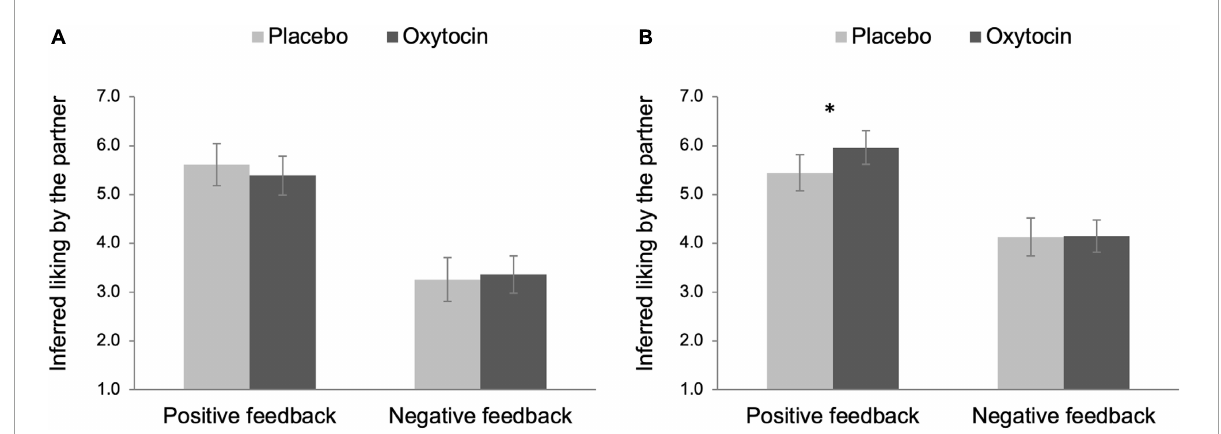
FIGURE4 Partner perception before (A) and after (B) the in-person interaction as a function of intranasal spray (placebo vs. oxytocin) in each feedback condition. Higher number indicates that participants perceived their partner to have more favorable attitudes toward them. Error bars indicate 95% confidence intervals. ∗ p <